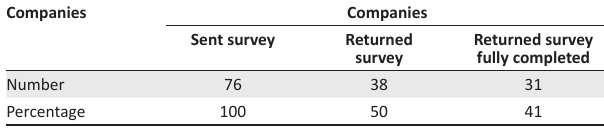
TABLE 2: Overall response rate of survey.